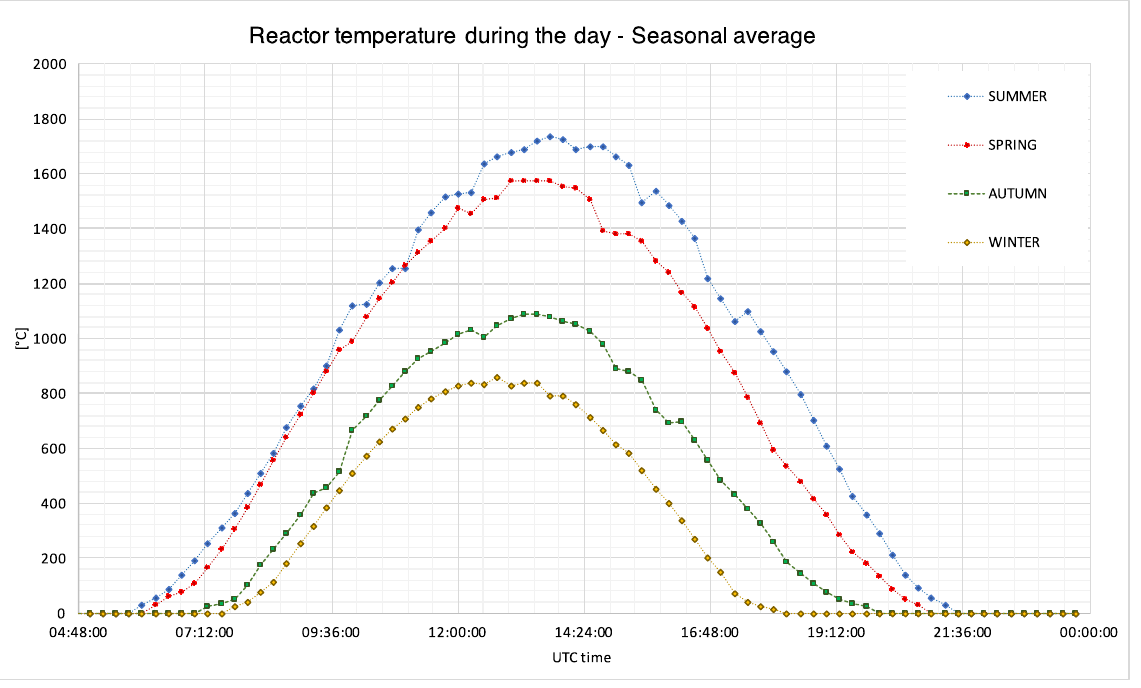
Figure 17. Reactor temperature during the day for different weather seasons. The time values were obtained as a result of the 2D model developed in Comsol